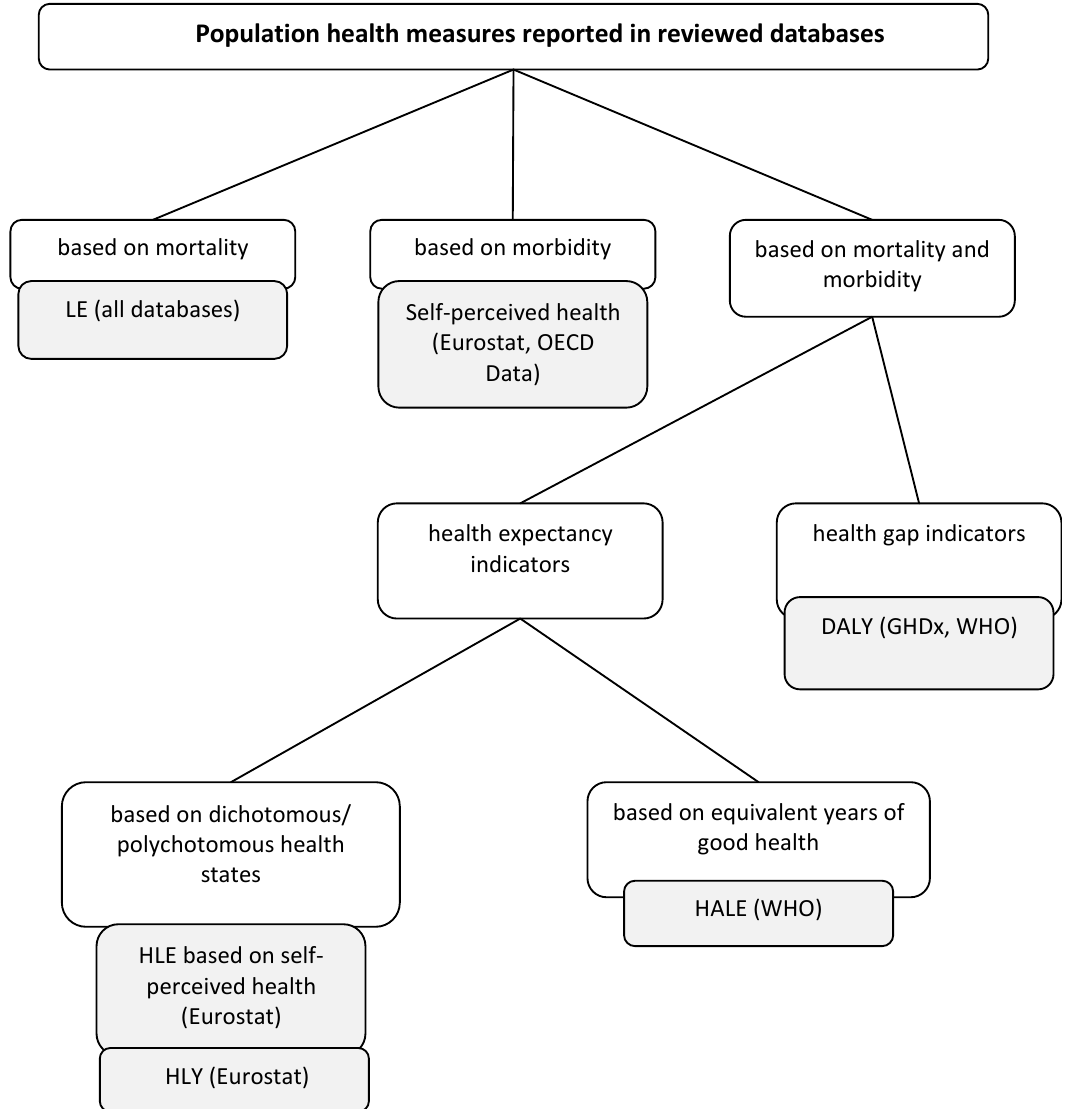
Figure 1. The general classification of population health status measures. Note: LE—life expectancy; DALY—disability-adjusted life years; HLE—healthy life expectancy based on self-perceived health; HLY—healthy life years; HALE—healthy life expectancy. Source: own work based on [6].